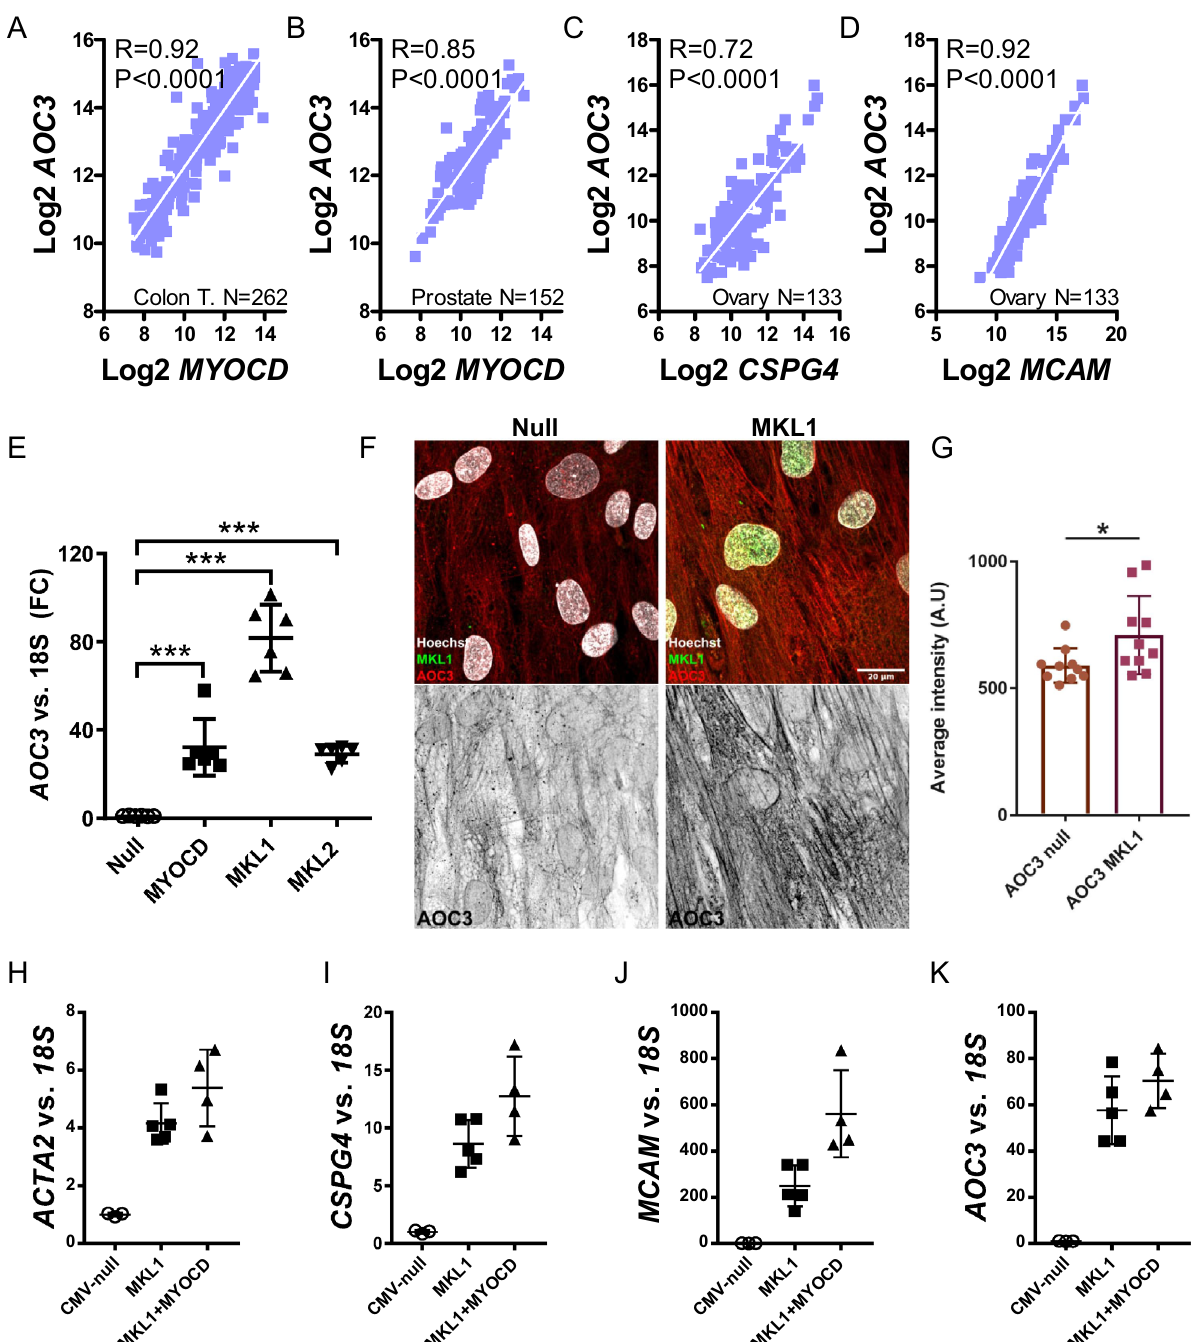
Figure 3. AOC3 also resides in the CSPG4 co-expression module and is regulated by MRTFs. Panels ( A ) and ( B ) show correlations between MYOCD and AOC3 in the colon and prostate, respectively. Panels ( C ) and ( D ) show that AOC3 also correlates with CSPG4 and MCAM (ovary). Panel ( E ) shows mRNA levels for AOC3 following overexpression of MRTFs (all statistical comparisons versus Null). Panel ( F ) shows confocal imaging of AOC3 fluorescence in cells transduced with Null virus and with MRTF-A/MKL1-encoding virus. Panel ( G ) shows summarized data from the experiments in ( F ). Panels ( H ) through ( K ) examine if MYOCD is antagonistic with MRTF-A/ MKL1 . No antagonism was noted for the classical target gene ACTA2 ( H ), for CSPG4 ( I ), for MCAM ( J ) or for AOC3 ( K ). *P < 0.05, ***P < 0.001, versus